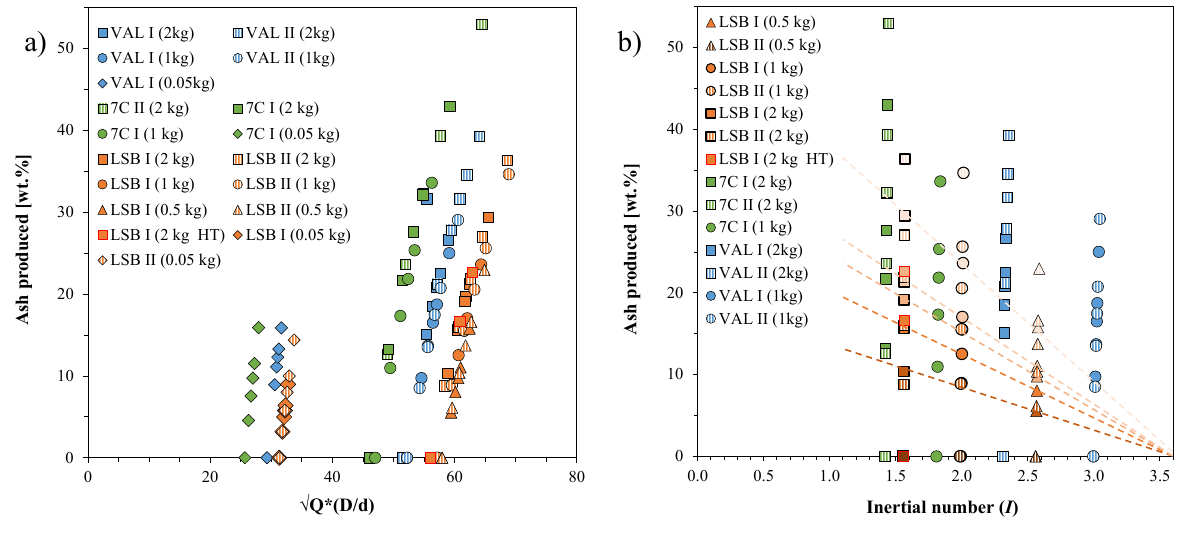
Figure 9: [A] Ash produced as a function of normalised flow rate ( √ Q ( D/d )) varies with starting mass and ∗ material, while type I and II experiments collapse onto a curve. Experiments in the small tumbler show a di ff erent trend (see inset), but maintain the relationship between the di ff erent materials. [B] Ash production is plotted as a function of the non-dimensional inertial number, I . Values of I increase with decreasing starting volume for a given material. Increasing tumbling distances are indicated with lighter coloured data points. For type I experiments of LSB, dashed lines are drawn between points at the same tumbling distance but with varying I value. These lines converge on the x-axis at at I 3 . 6, indicating that ash produced is a function of I and tumbling ≈ distance for these